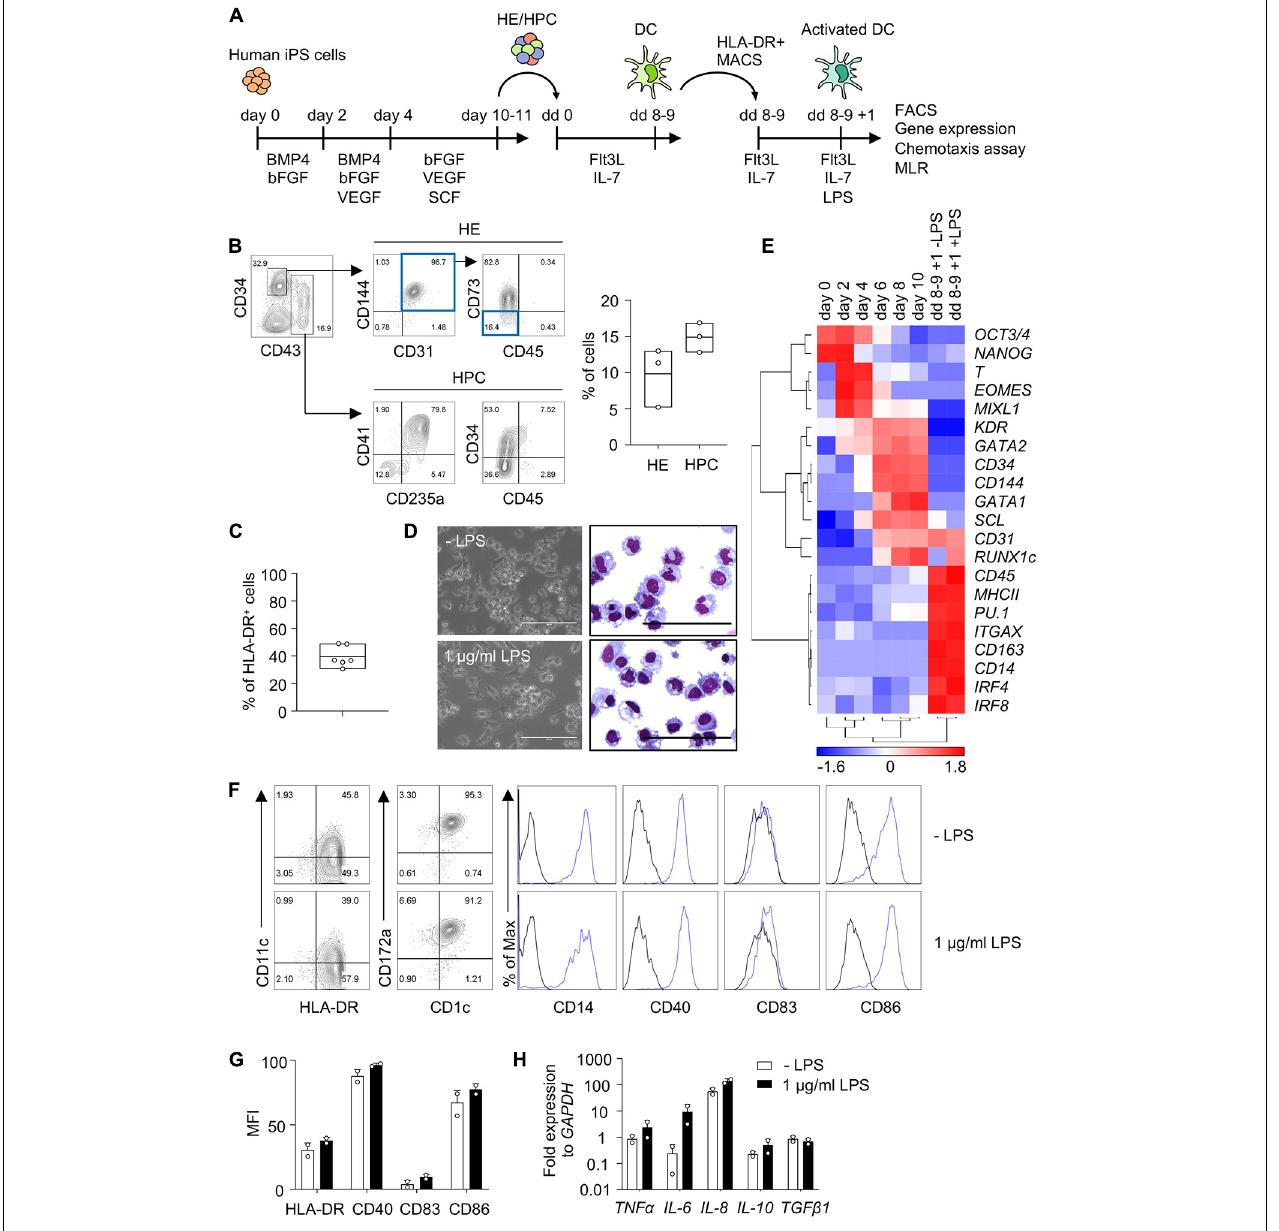
FIGURE 1 | Human iPS cells differentiate into DC in EB and Flt3L + IL-7 cultures. (A) Schematic representation of iPS cell differentiation into DC. Human iPS cells were differentiated into HE and HPC for 10–11 days in spin EB culture with consecutive supplementation of cytokines as indicated. HE and HPC were then cultured for 8–9 days with Flt3 ligand (Flt3L) and IL-7 to induce DC differentiation (dd 0 to dd 8–9). HLA-DR + cells were isolated by immunomagnetic bead selection (MACS) and stimulated with 1 µ g/ml LPS for 1 day (dd 8–9 + 1). These cells were used for further analysis as indicated. (B) Representative flow cytometry analysis and quantification of HE (CD34 + CD31 + CD144 + CD43 − CD45 − CD73 − cells; blue boxes) and HPC (CD43 + CD34 low / − cells) in EB on day 10 of spin EB differentiation. n = 3, line represents mean. (C) Frequency of HLA-DR + cells on day 8–9 of DC differentiation. n = 6, line represents mean. (D) Representative photomicrographs of unstimulated and LPS-stimulated HLA-DR + cells in culture (left) and in cytospin preparations stained with Diff-Quik (right). n = 6, scale bars: 100 µ m. (E) Gene expression profiling of iPS cells (day 0) and EB on day 2–10 of spin EB differentiation, and unstimulated and LPS-stimulated HLA-DR + cells on day 8–9 + 1 of DC differentiation by RT-qPCR analysis. Expression values were normalized to GAPDH and (cid:49) Ct value over 12 was regarded as not-expressed and arbitrarily set to 12. z-scores of − (cid:49) Ct mean calculated for each gene are shown in heat map format (red, high expression; blue, low expression). n = 2. (F,G) Representative flow cytometry analysis and quantification of median fluorescent intensity (MFI) of DC markers on unstimulated and LPS-stimulated CD1c + HLA-DR + cells. Blue lines and black lines in histograms represent stained and unstained cells, respectively. MFI values were normalized to unstained cells. (G) n = 2, mean ± SD. (H) Cytokine expression in LPS-stimulated CD1c + HLA-DR + cells by RT-qPCR analysis. Unstimulated cells (-LPS) are shown as control. Values were normalized to GAPDH and 2- (cid:49) Ct values in log scale were shown. n = 2, mean ± SD. All data shown in (B – H) are from healthy control iPS cells. Data in (D,F) are representative for healthy control and patient PV1 and PV2 iPS cells. n = 2–6.